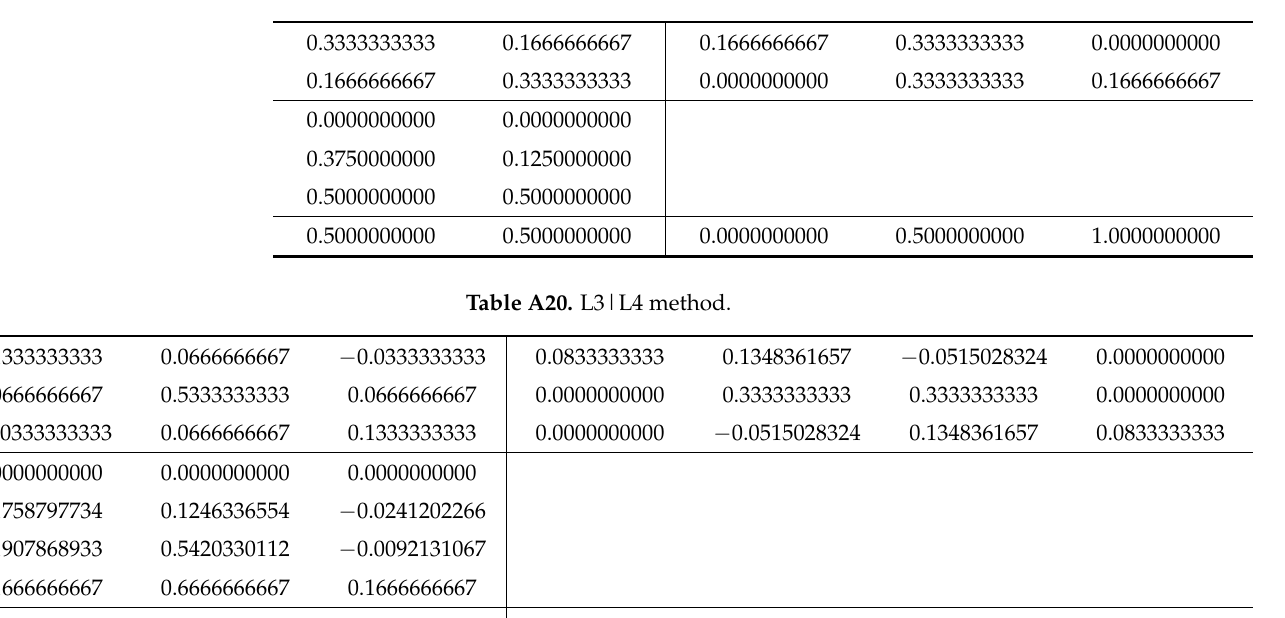
Table A19. L2|L3 method.